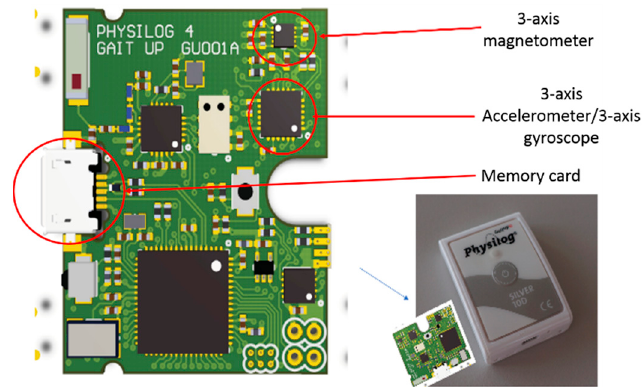
Figure 1. Physilog module from Gait Up.